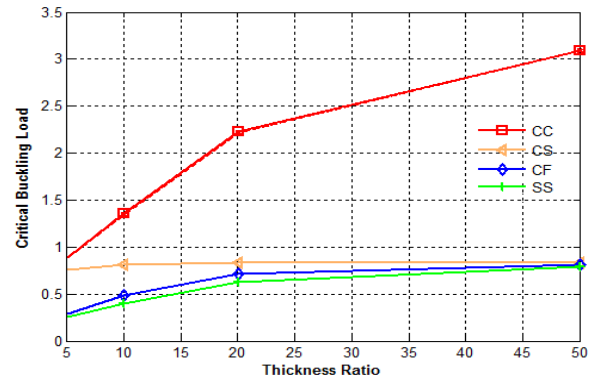
Figure 5: Effect of boundary condition on critical buckling load under N m x